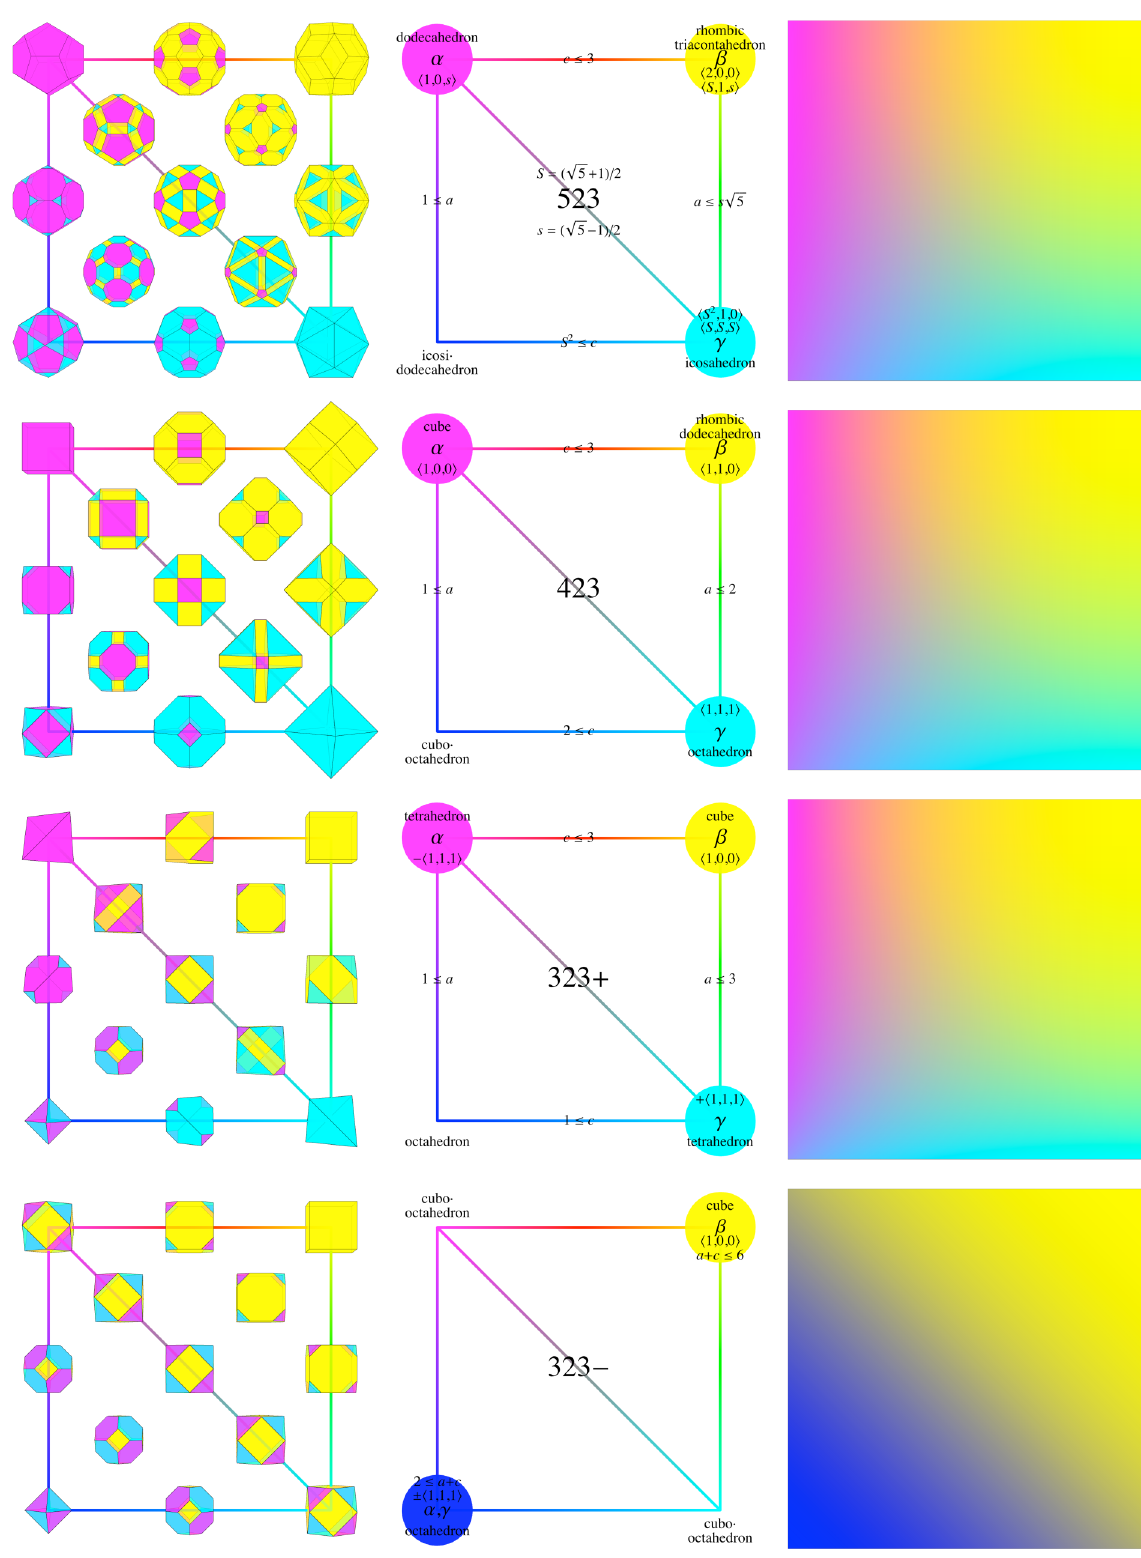
FIG. 3 Left column: Representative polyhedra for the families 523, 423, 323 þ , and 323 − . The two pairs of diagonally opposite corners correspond to dual polyhedra. The 323 family also has reflection symmetry about the diagonal a ¼ c . Middle column: The direction of face-normal vectors f α ; β ; γ g , the parameter range h a; c i , and the names of the corner polyhedra. Right column: A color map of the surface-area fraction of face types. In all columns, the color {magenta, yellow, and cyan} indicates the type of face f α ; β ; γ g